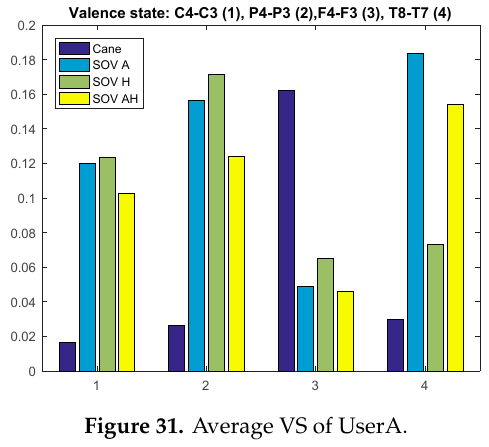
Figure 31. Average VS of UserA.